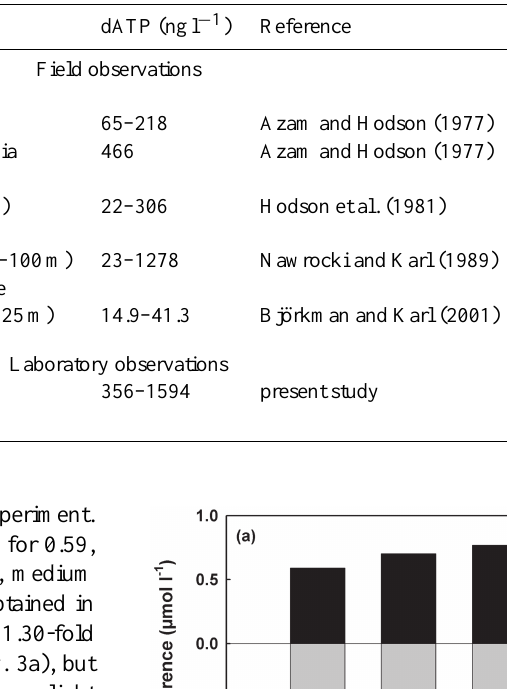
Table 2. Observed dATP values based on literature data from different oceanic regions.